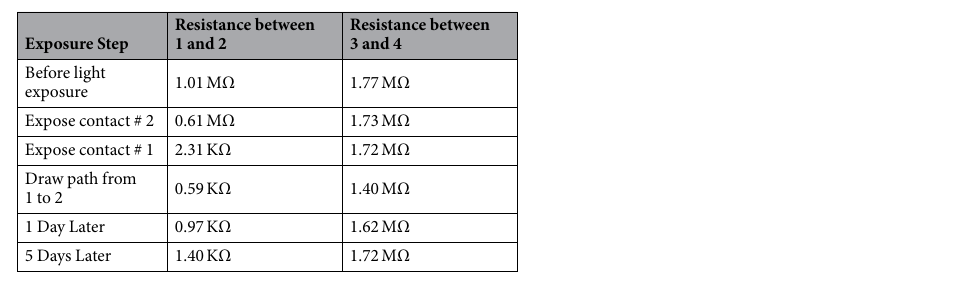
Table 1. Resistance values after exposure with a 405 nm laser diode (see Fig.